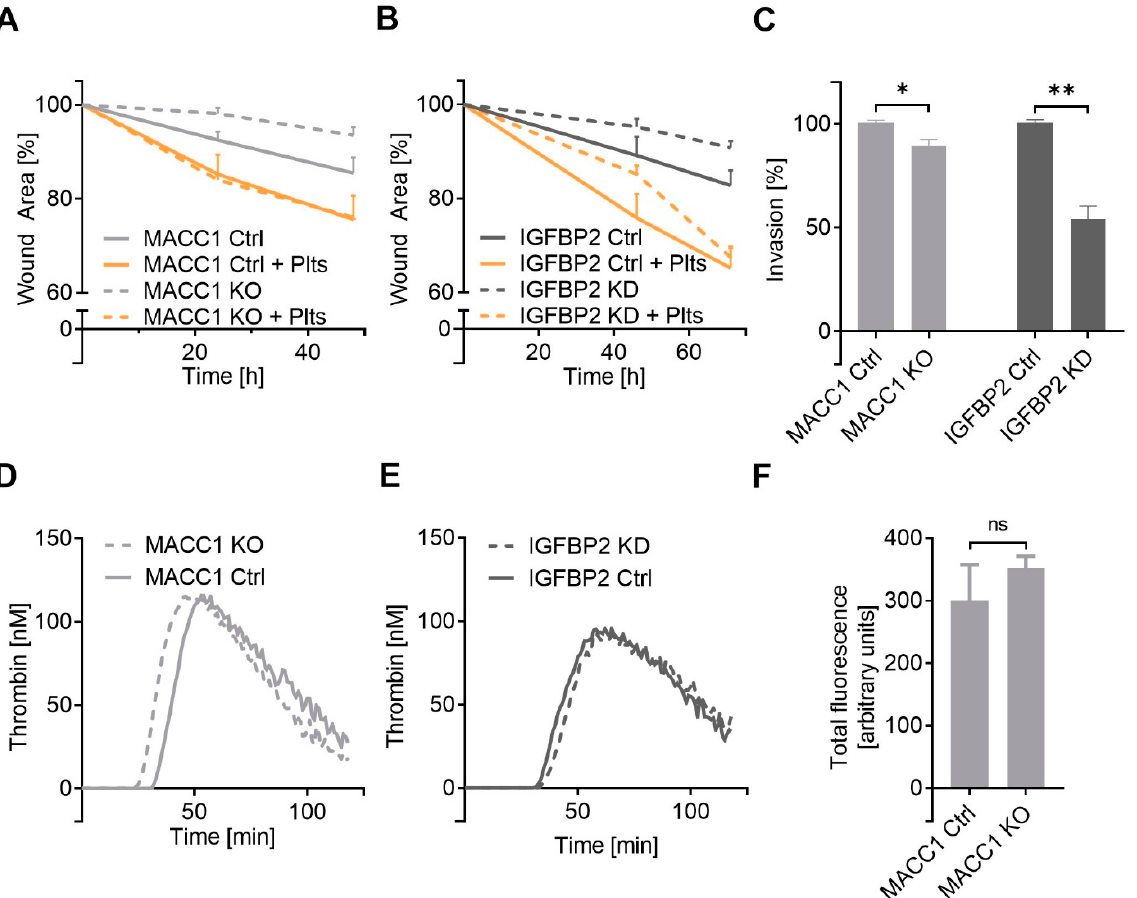
Figure 5. The impact of IGFBP2 as a functional downstream component of MACC1 on SW620 cell dynamics. ( A,B ) Detection of cell migratory dynamics in a 2D wound healing assay comparing the impact of MACC1 ( A ) and IGFBP2 ( B ) on migration and the effect of platelets to accelerate dynamic properties. ( C ) Analyzing cell invasion in a transmigration assay and the impact of MACC1 knockout or IGFBP2 knockdown. ( D,E ) Analyzing the impact of MACC1 KO or IGFBP2 KD on cell capability to induce coagulation indicates no differences in thrombin formation upon MACC1 KO ( D ) or IGFBP2 KD ( E ) when compared to the respective control cells. ( F ) Flow cytometry data confirm that the knockout of MACC1 in SW620 cells has no impact on tissue factor expression. * p < 0.05; ** p < 0.01, ns =